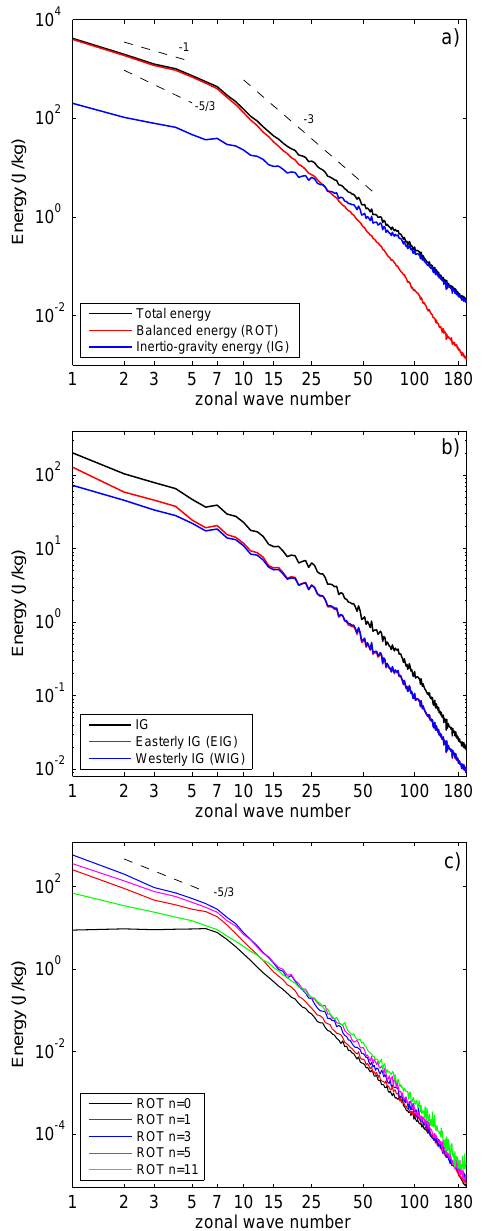
Figure 6. Atmospheric energy spectra. (a) Energy distribution in balanced (red line) and inertio-gravity (blue line) motions and their sum (total wave energy, in black) as a function of the zonal wave number; (b) same as (a) but IG (black), EIG (red) and WIG (blue); (c) same as (a) but balanced spectra for meridional modes n = 0, 1, 3, 5, 11. Spectra are obtained by averaging 30years of outputs from ERA Interim, 12:00UTC analysis. Summation is performed over (a, b) all (m,n) and (c) all m and the mean state ( k = 0) is not included. Short dashed lines (black) correspond to the spectra with slopes − 3, − 1 and − 5 / 3 as written next to the lines.